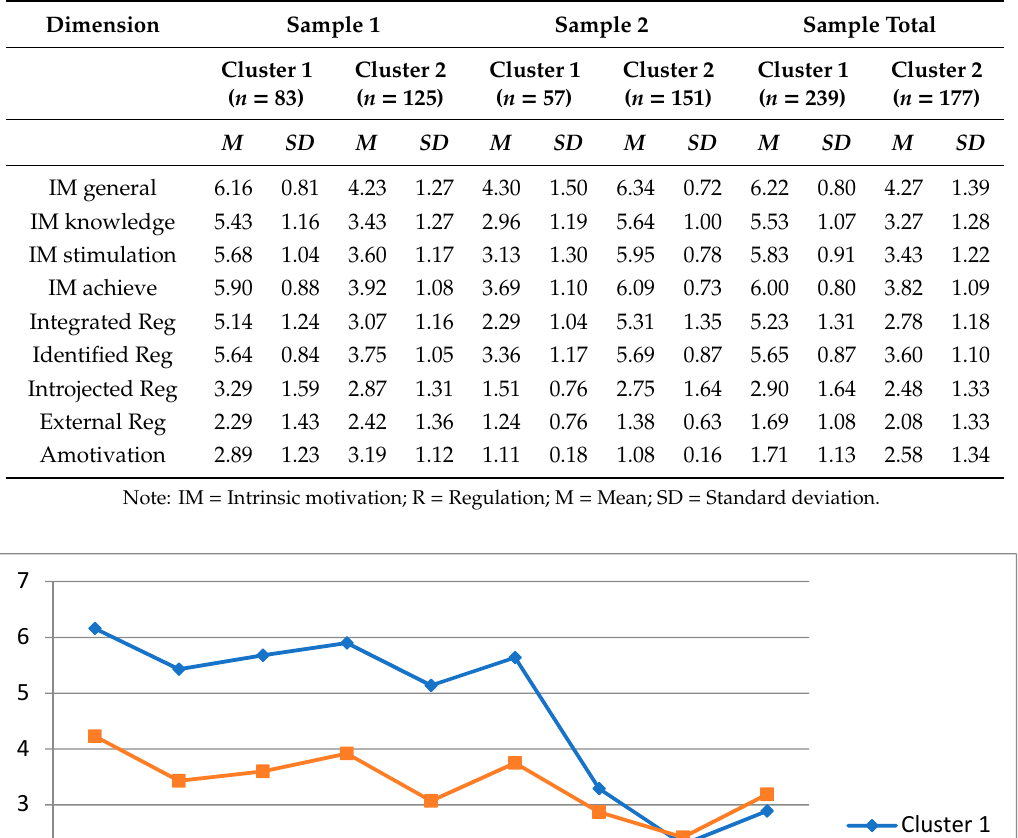
Table 3. Means and standard deviations for the variables in each cluster for each sample. Dimension Sample 1 Sample 2 Sample Total Cluster 1